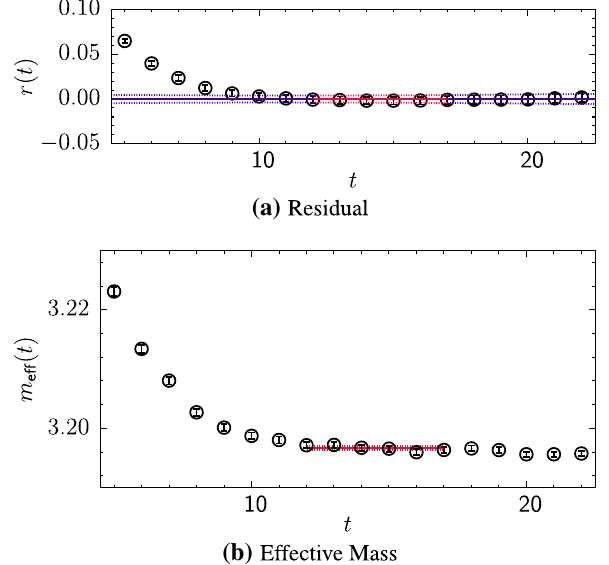
Fig. 2 Correlatedfitresultsforapseudoscalarbottomoniumcorrelator generated with the OK action at κ = 0 . 041 and p = 0 . a Residual defined in Eq. (29) and its statistical error from a fit over 12 ≤ t ≤ 17. b Effective mass (points) defined in Eq. (28) with fit result for the ground-state energy E (horizontal red line plotted over the chosen fit interval)